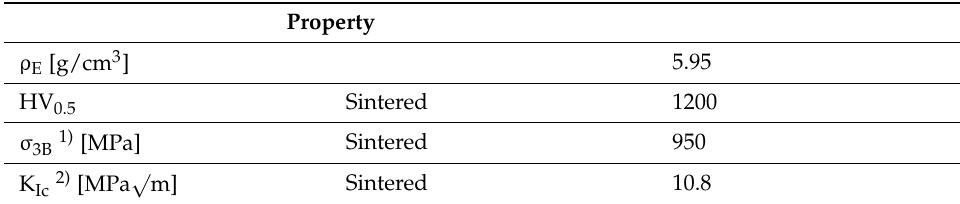
Table 7. Mechanical properties of Ce-TZP/LaAl 11 O 18 composite.